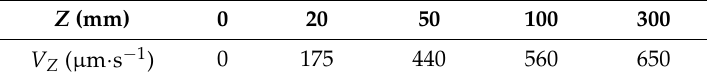
Table 3. Growth rate V Z at several distances Z from fusion line.